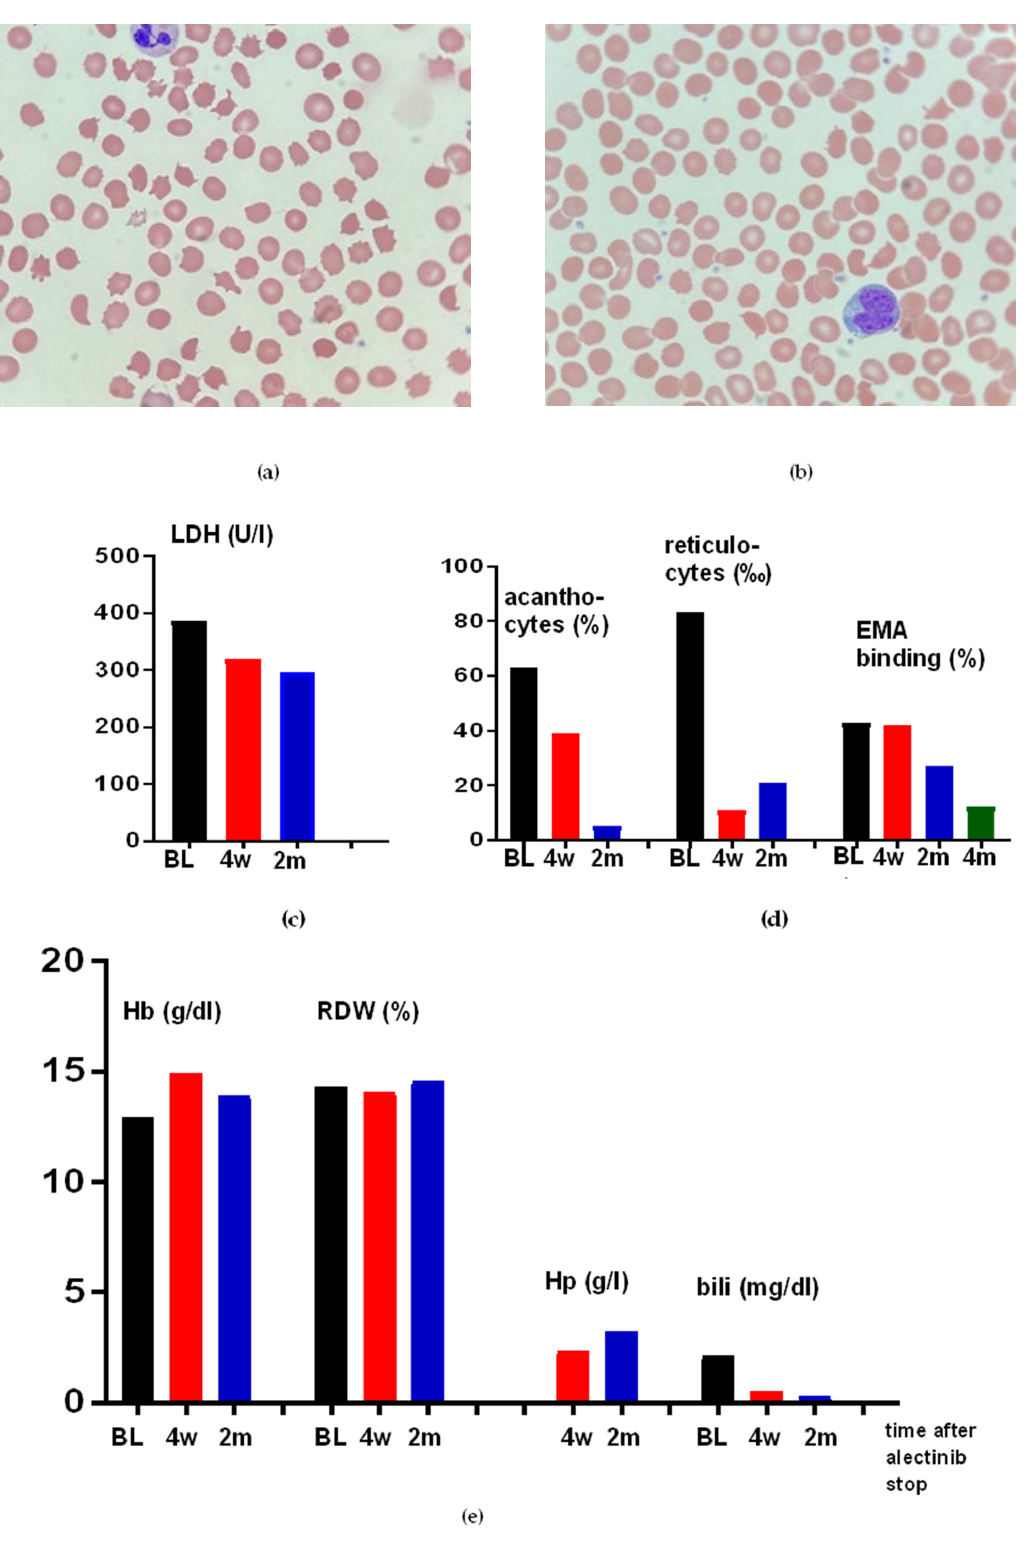
Figure 2. Resolution of erythrocyte changes after alectinib stop in patient 1 (Table 1). ( a ) Peripheral blood film at 100 × magnification showing abnormal red cell morphology during therapy with alectinib. ( b ) Blood smear 4 weeks after the switching of therapy to brigatinib at 100 × magnification with the return of some normal erythrocytes. ( c – e ) Longitudinal resolution or improvement of other changes in the same patient after alectinib stop; BL: baseline; 4 w: 4 weeks after treatment stop; 2 m: 2 months after treatment stop. The coexistence of acanthocytes and spherocytes together with the reduced EMA binding in most patients was reminiscent of hereditary spherocytosis. This differential diagnosis was particularly relevant for one of our cases (#1 in Table 1), who, aside from hemolysis under alectinib, also showed a paravertebral mass suggestive of extramedul- lary hematopoiesis in the spine MRI that already existed before the initiation of therapy. However, genetic testing by NGS showed no mutations in ANK1 , EPB42 , SLC4A1 , SPTA1, or SBTB genes in this and an additional two patients, thus ruling out hereditary sphero- cytosis in all studied cases (Table 1). Hematologic changes under alectinib appeared to be specific to this particular drug because they were not observed in patients treated with crizotinib, brigatinib, or lorlatinib (cases 1, 14–18, Table 1). In addition, they appeared to be reversible, as is evident by the prompt resolution in a patient who was switched from alectinib to brigatinib due to tumor progression (case 1, Table 1): the blood smear after 4 weeks showed a significantly de- creased number of pathologically altered erythrocytes (10% vs. 40% before the change of therapy, Figure 2). In contrast, the changes in EMA binding assay resolved more slowly, from 43% at the time of the therapy switch to 42% 4 weeks later, 28% 9 weeks after the start of brigatinib (Table 1), and after another 5 weeks, the EMA binding was in the normal range (12%, NB. The patient, meanwhile, received lorlatinib due to a new tumor progres- sion under brigatinib). Median follow-up from the start of therapy for metastatic ALK+ NSCLC for our alec- tinib-treated patients ( n = 19, Table 1) was 57 months (95% confidence interval (CI) 28.1– 86.1 months), while their median OS was not reached (3/19 events so far). The median follow-up for PFS under alectinib was 39.5 months (95% CI 29.7–49.3 months), and the median PFS was not reached either (3/19 events). PFS under alectinib showed no